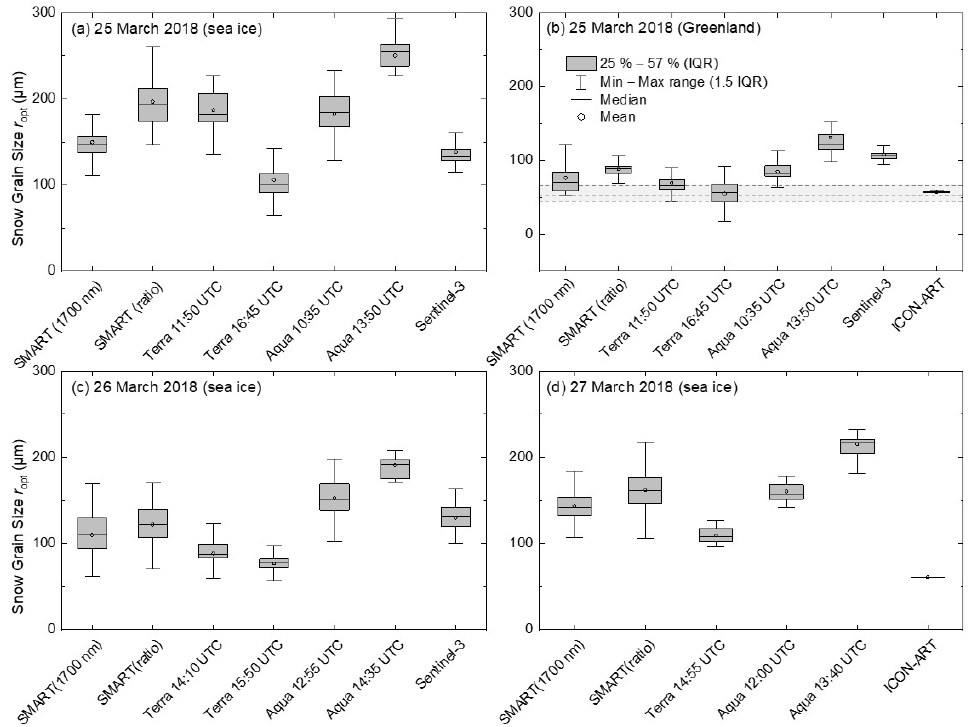
Figure 8. Box-and-whisker plot of snow grain size statistics along the entire flight track over sea ice ( a ) and over Greenland ( b ) on 25 March 2018, as well as over sea ice on 26 March 2018 ( c ), and on 27 March 2018 ( d ). Minimum and maximum values (without statistical outliers) are displayed as vertical bars. The boxes indicate the 25th, 50th (median), and 75th percentiles of the distribution. IQR stands for interquartile range. The mean r opt and the range of measurement uncertainty of the IceCube data is shown as horizontal light gray bar in ( b